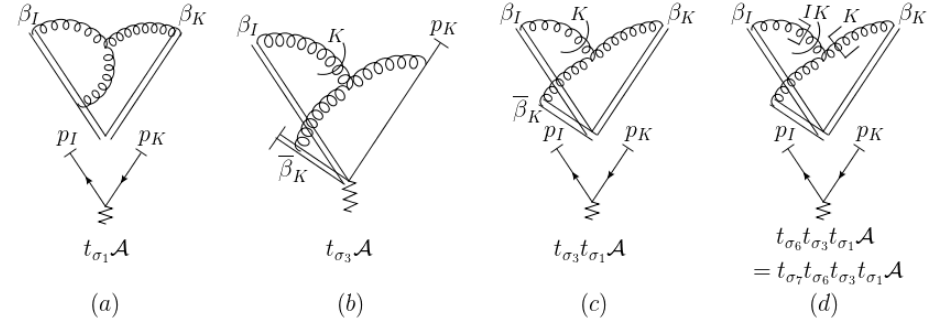
Figure 36. Pictorial representations of the selected subtraction